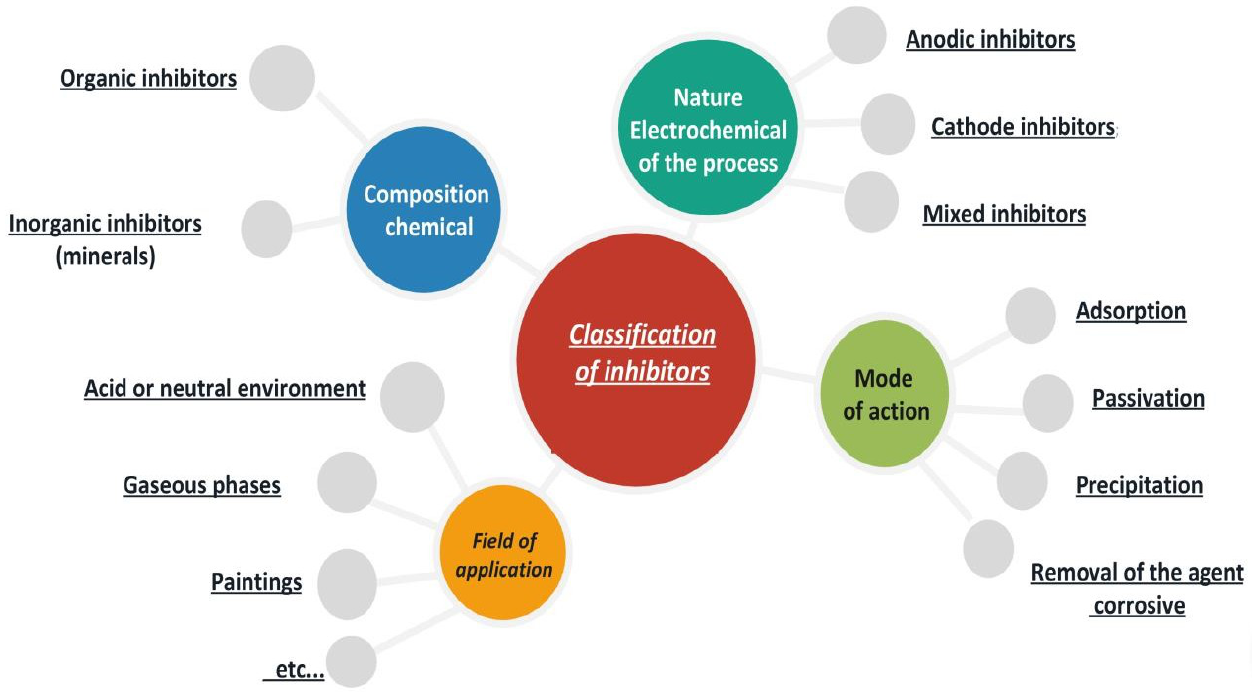
Figure 8. Classification of corrosion inhibitors .